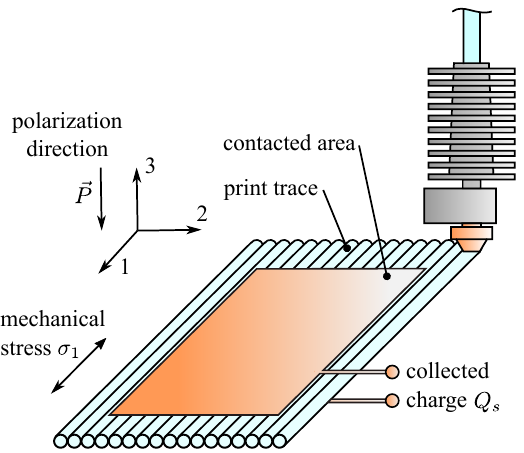
Figure 1. Coordinate system for a piezoelectric PVDF film fabricated with ME.